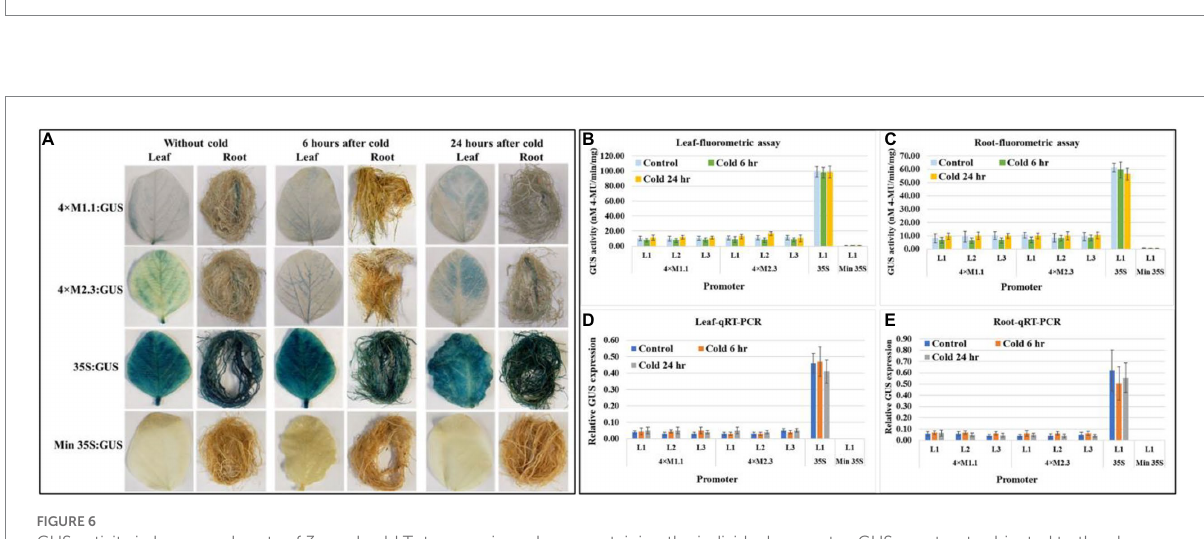
FIGURE 6 GUS activity in leaves and roots of 3-week-old T 3 transgenic soybean containing the individual promoter-GUS construct subjected to the absence (untreated control) and presence (treated) of cold (4 ° C) at two time points of 6 and 24 h after treatment. (A) Histochemical staining for GUS activity in transgenic soybean plants. (B,C) Fluorometric assay for GUS activity in leaf (B) and root (C) . (D,E) Quantitative real-time RT-PCR (qRT-PCR) analysis for GUS expression in leaf (D) and root (E) . The relative levels of transcripts in qRT-PCR were normalized to soybean ubiquitin gene ( GmUBI 3). Three independent transgenic lines (L1, L2, and L3) were used for 4 × M1.1 and 4 × M2.3 promoter-GUS constructs. One transgenic line (L1) was used for 35S and minimal (Min) 35S promoter-GUS constructs. Bars represent mean values of six biological replicates ± standard error. Statistical significance ( p < 0.05) was determined by two-sample paired t -test. Bars with asterisk (*) indicate significant difference compared to untreated control